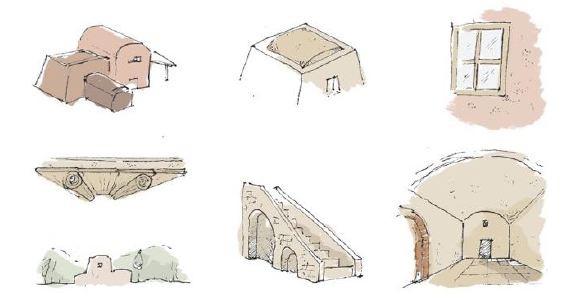
Figure 5. Architectural features of Phlegrean